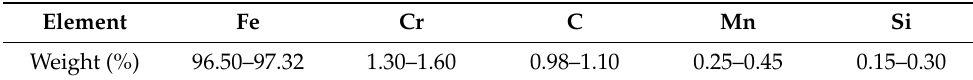
Table 2. AISI 52100 steel chemical composition properties